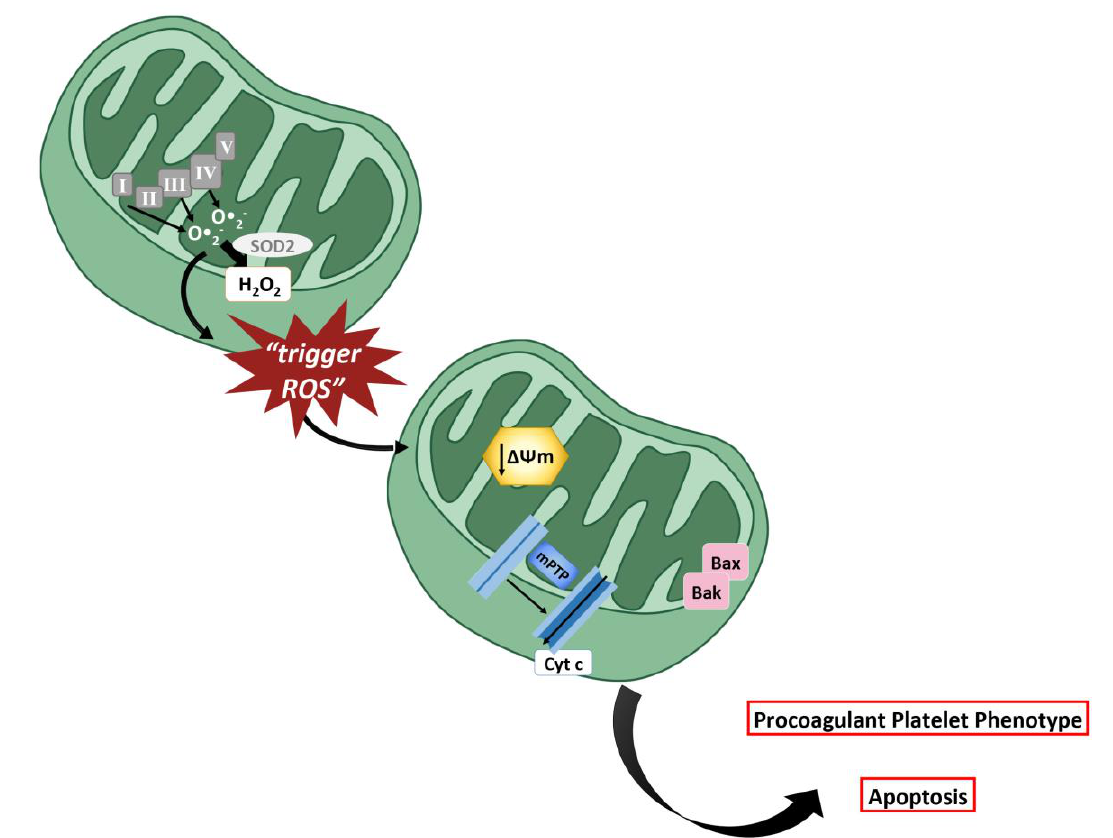
Figure 4. Platelet mitochondria in redox balance. During oxidative phosphorylation, mitochondria produce ROS. Complex I and III of ETC (electron transport chain) are the main sources of mitochondrial ROS, called trigger ROS. Trigger ROS are released in the cytoplasm and, through a positive